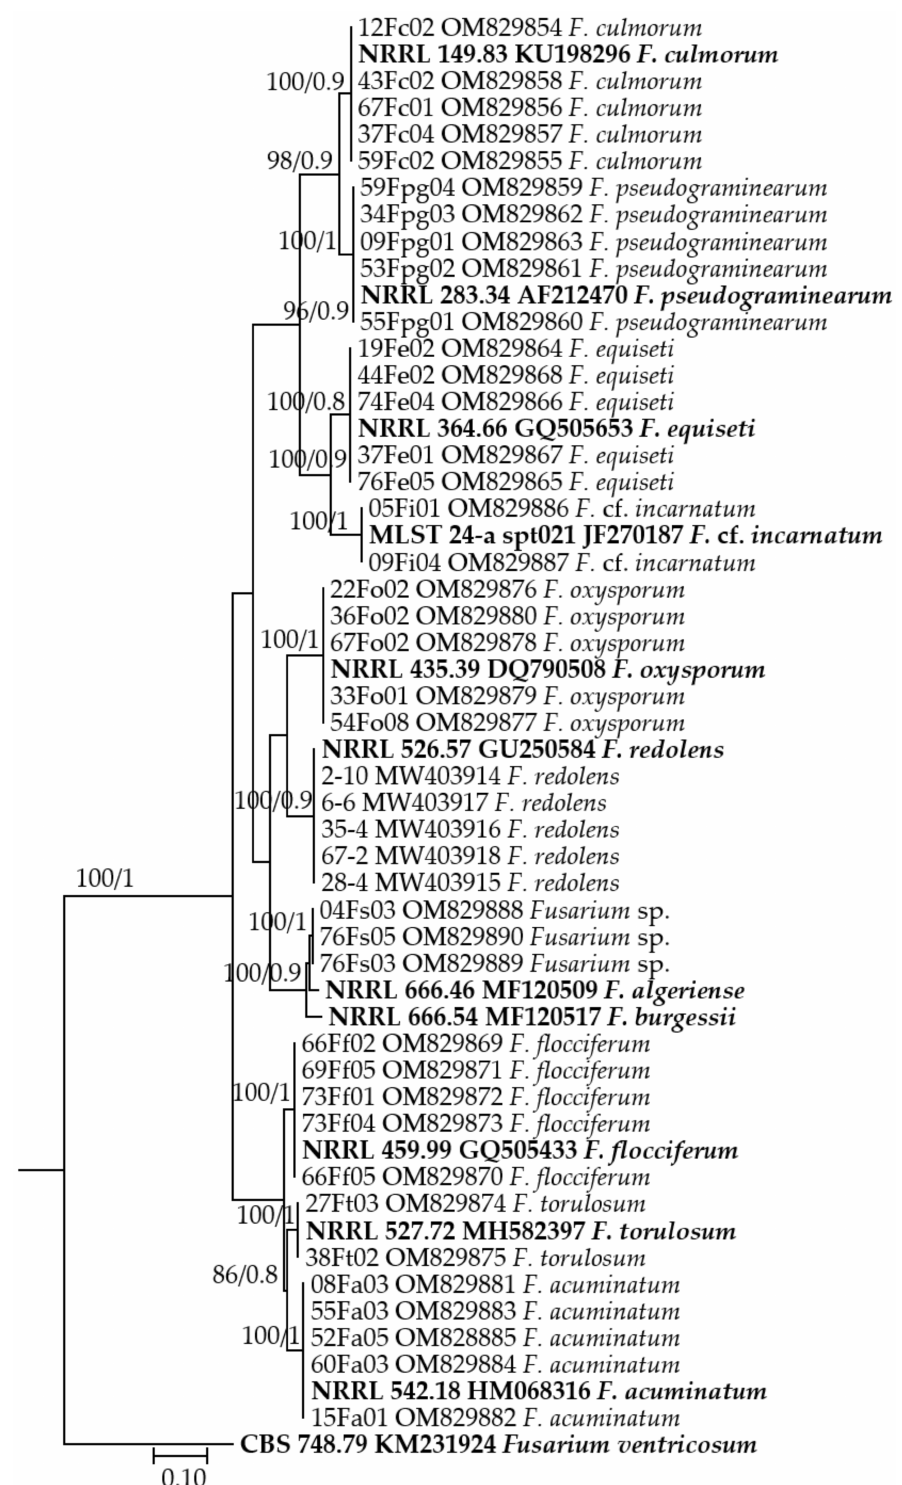
Figure 2. Phylogenetic tree based on maximum likelihood using IQ-TREE and Bayesian inference (BI) using MrBayes with EF1- α sequences of Fusarium isolates. At each node are the bootstrap values (left) and posterior probabilities (right). Sequences used as references and outgroups in the present study are presented in